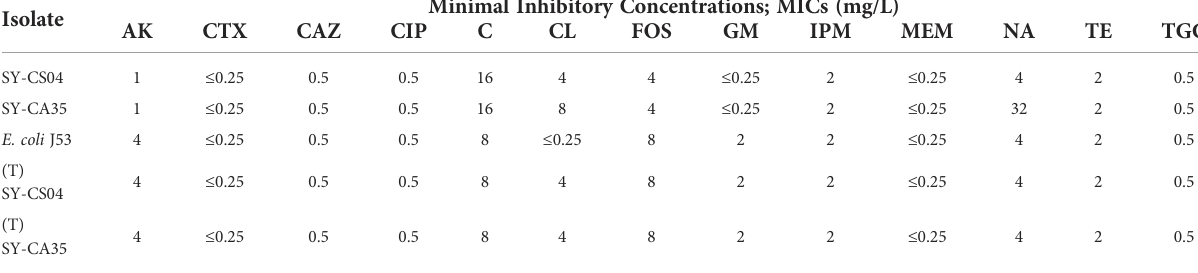
TABLE 1 The minimum inhibitory concentrations (MICs) of bacterial isolates.